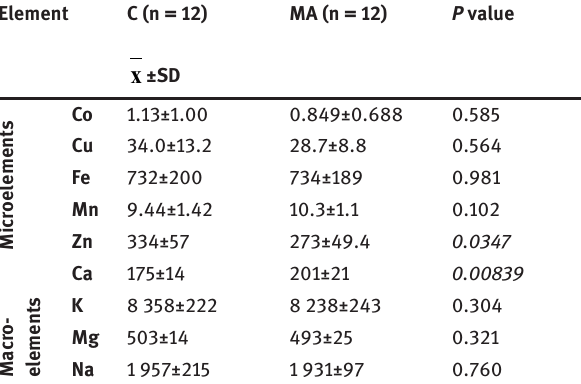
Table 9: The effect of enriched macroalgae on the average content of elements in liver of examined pigs (mg kg -1 ).